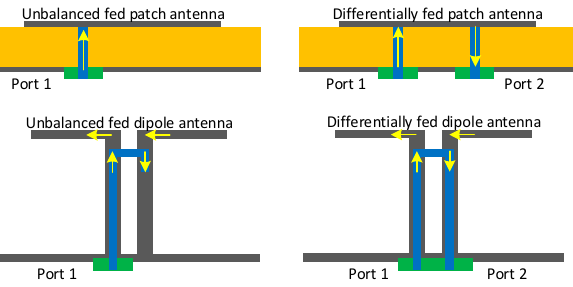
Figure 7. Illustration of unbalanced fed and differentially fed patch and dipole antennas.